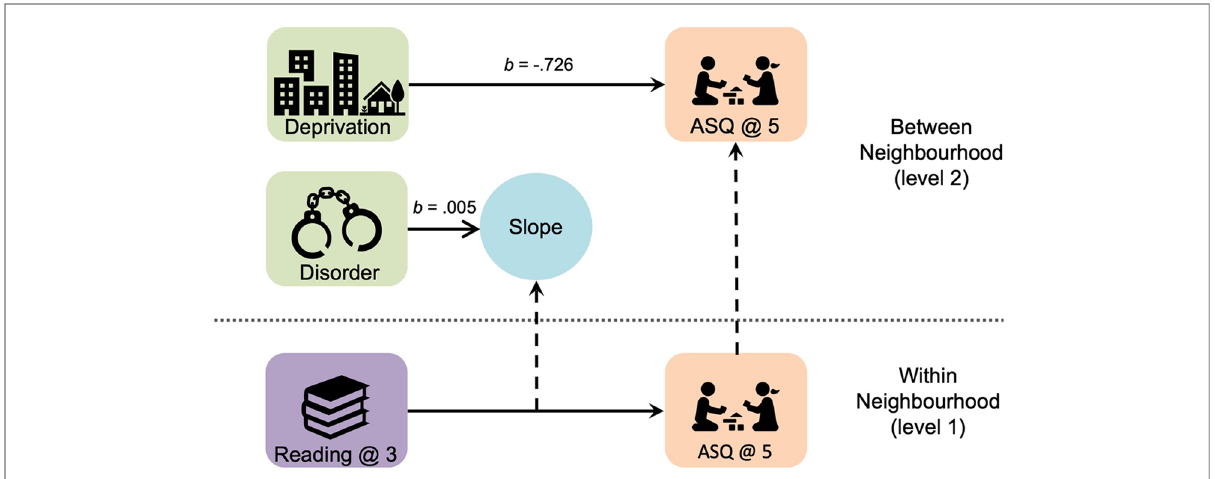
FIGURE 1 Main and moderation effects of neighbourhood characteristics on child development. Solid arrows represent regression paths, dashed arrows represent parameters brought from the within to the between neighbourhood level. Moderation is represented by the regression of neighbourhood disorder on the slope for Reading to ASQ. ASQ, ages and stages